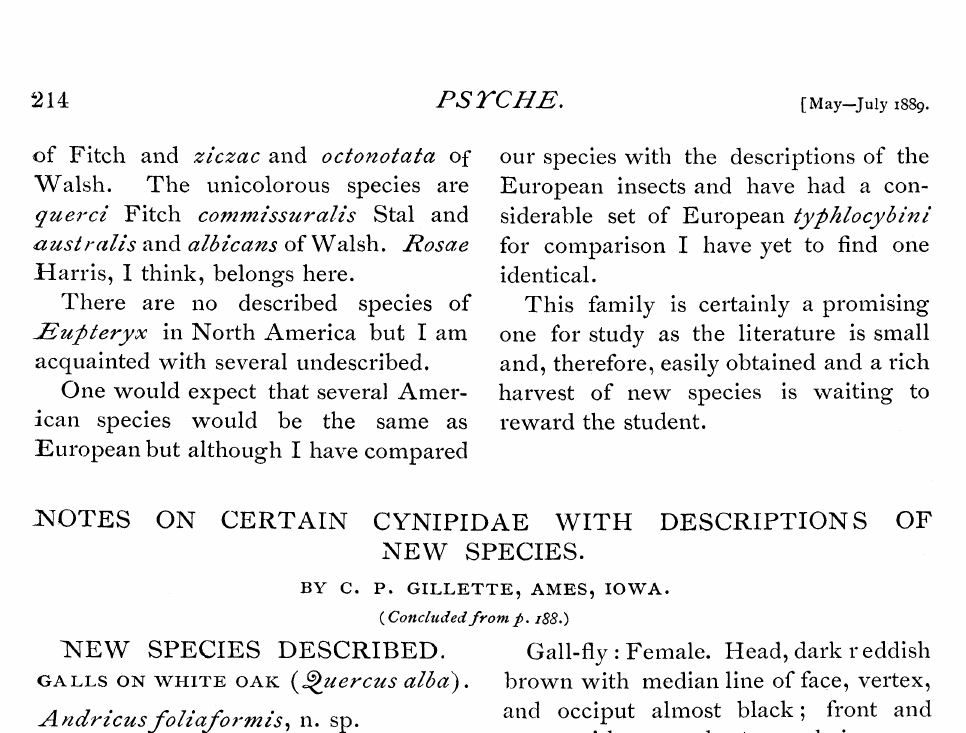
Parapsidal grooves distinct but not deep outside of the grooves on either side a longitudinal patch of black is separated from the central black portion by a yellowish-brown Iine along either groove. Dorsal portion of thorax sparsely haired; pleurae rather densely haired; tegulae brown. Abdomen brown, smooth and shining, the dark- est portion being on the posterior dorsal part. With a power of 5 diameters, minute punctures can be seen on the abdominal segments; second segment sparsely haired on sides. Scutellum with two fovae at base separated fi’om each other by a narrow ridge; rounded behind, black at base, changing Fig.